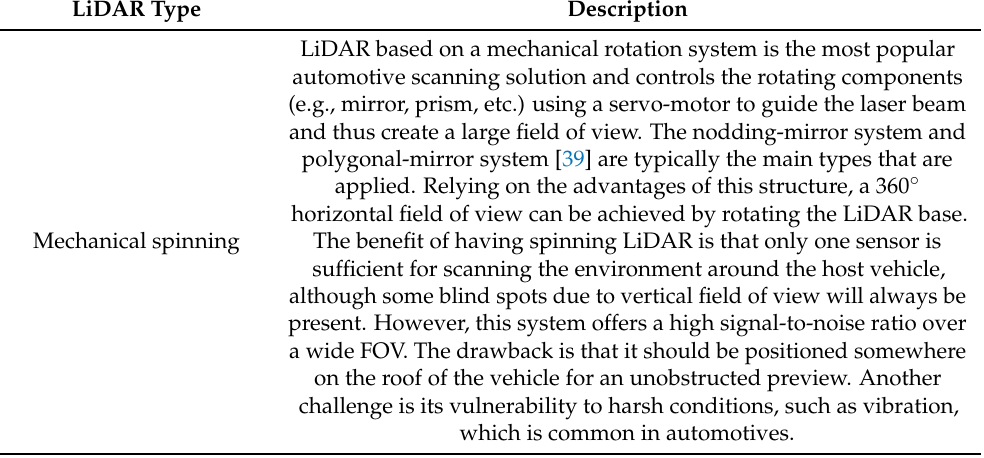
Table 3. Types of LiDAR used in